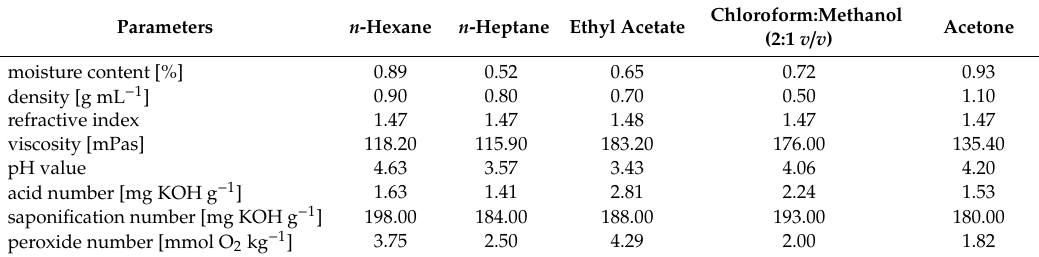
Table 2. Physico-chemical properties of plum seed